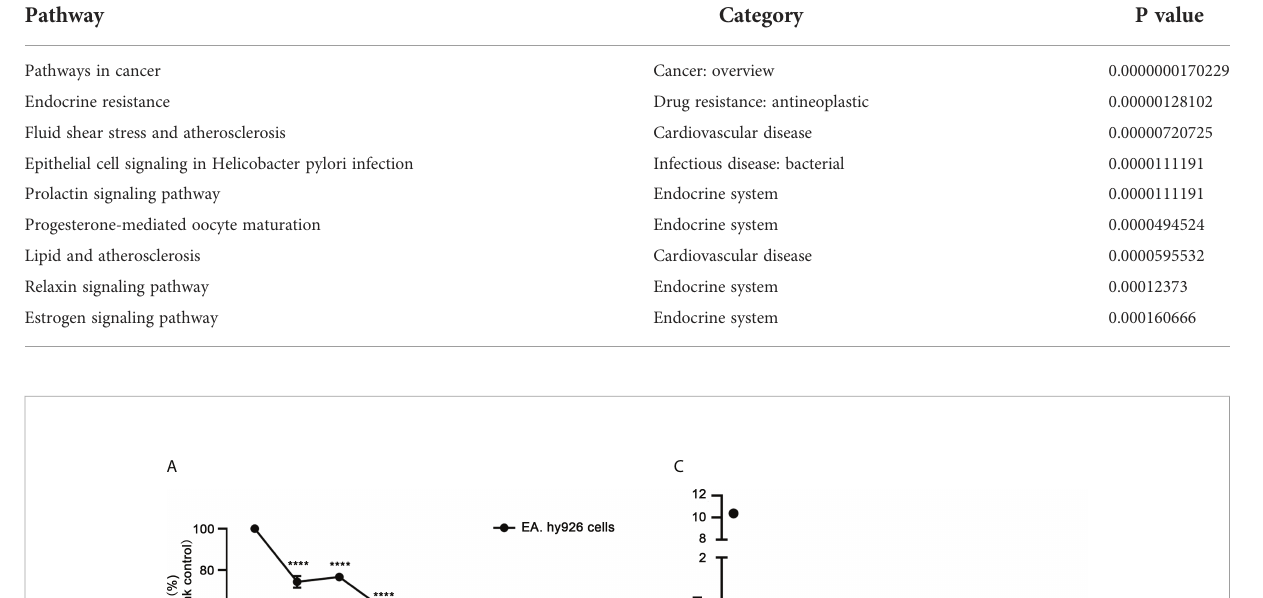
TABLE 1 KEGG pathways affected by both Cur and Bai against endothelial dysfunction.